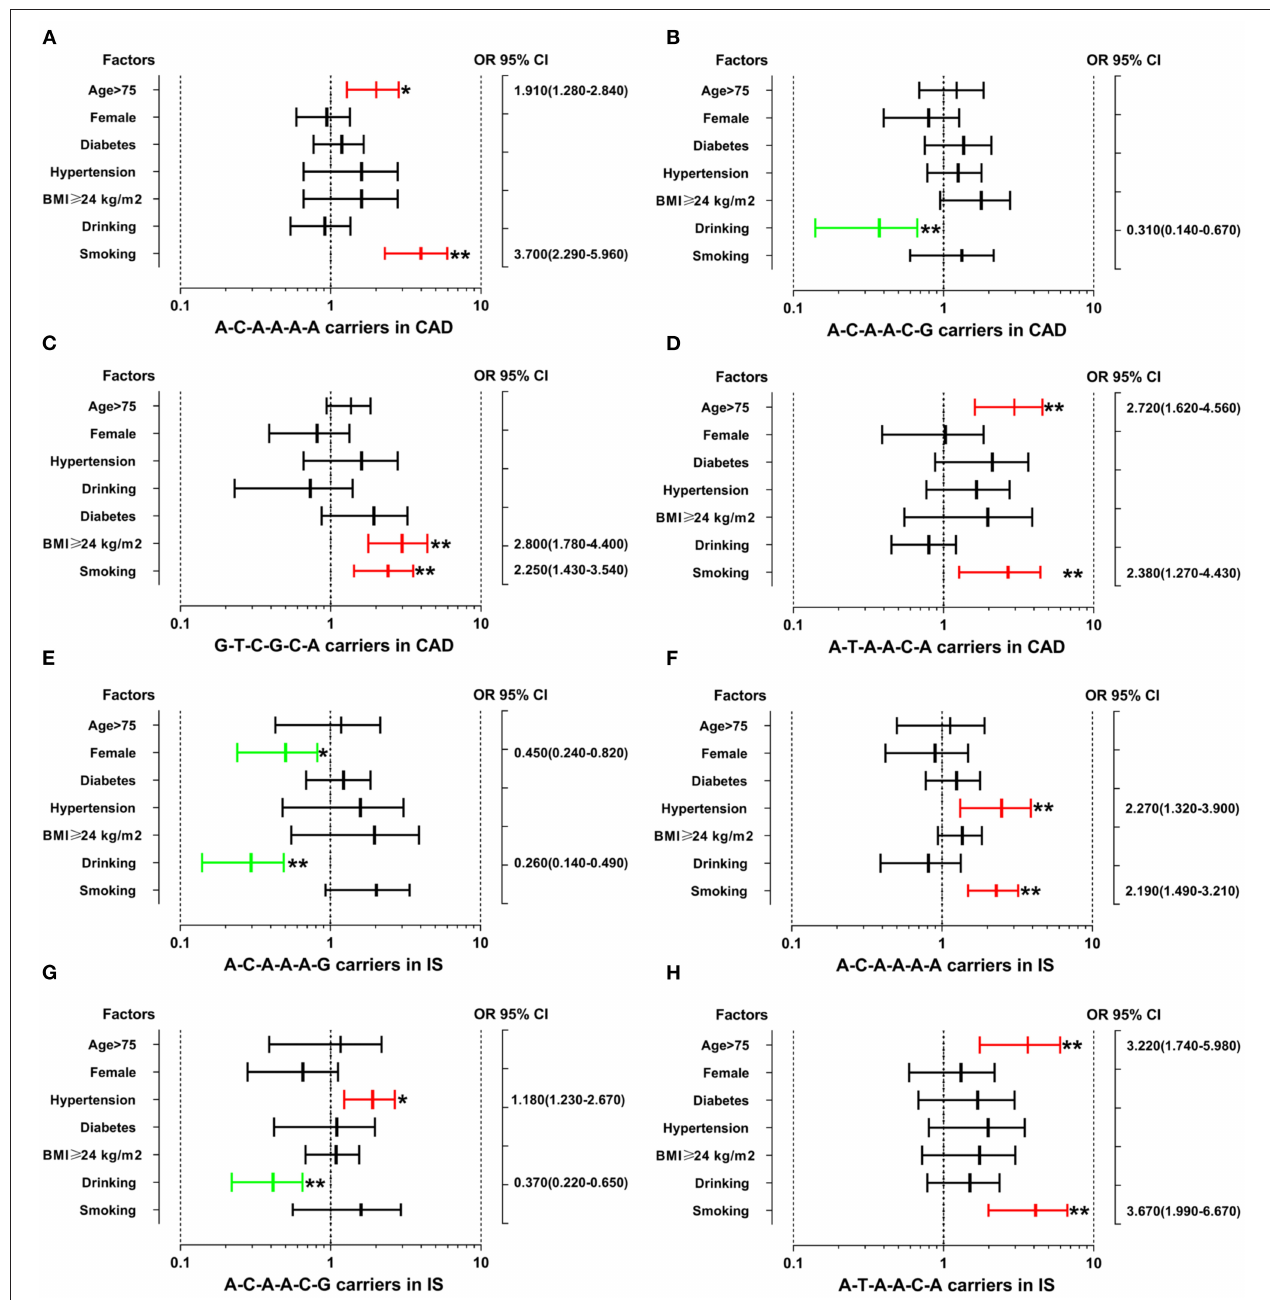
FIGURE 3 | The interactions between the SYTL3 - SLC22A3 haplotypes and the risk of CAD and IS. CAD, coronary artery disease; IS, ischaemic stroke. (A) The SYTL3 - SLC22A3 A-C-A-A-A-A haplotype interacted with age > 75 and smoking to increase the risk of CAD. (B) The interaction between the SYTL3 - SLC22A3 A-C-A-A-C-G haplotype and alcohol consumption decreased the risk of CAD. (C) The interactions between SYTL3 - SLC22A3 G-T-C-G-C-A and cigarette smoking and BMI ≥ 24 kg/m 2 increased the risk of CAD. (D) The SYTL3 - SLC22A3 A-T-A-A-C-A haplotype interacted with age > 75 and smoking to increase the risk of CAD. (E) The interactions between the SYTL3 - SLC22A3 A-C-A-A-A-G haplotype and female and alcohol consumption decreased the risk of IS. (F) The SYTL3 - SLC22A3 A-C-A-A-A-A haplotype interacted with hypertension and smoking to increase the risk of IS. (G) The interactions between the SYTL3 - SLC22A3 A-C-A-A-C-G haplotype and hypertension increased the risk of IS, and alcohol consumption decreased the risk of IS. (H) The interactions between the SYTL3 - SLC22A3 A-T-A-A-C-A haplotype and age > 75 and smoking increased the risk of IS. * P < 0.05 and ** P < 0.01.